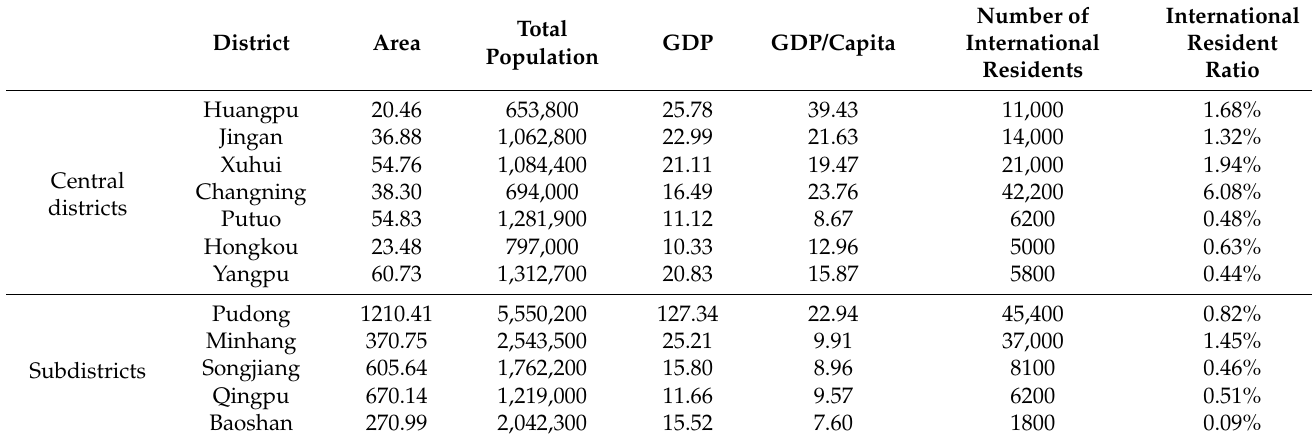
Table 2. Basic socioeconomic data per district, 2019.